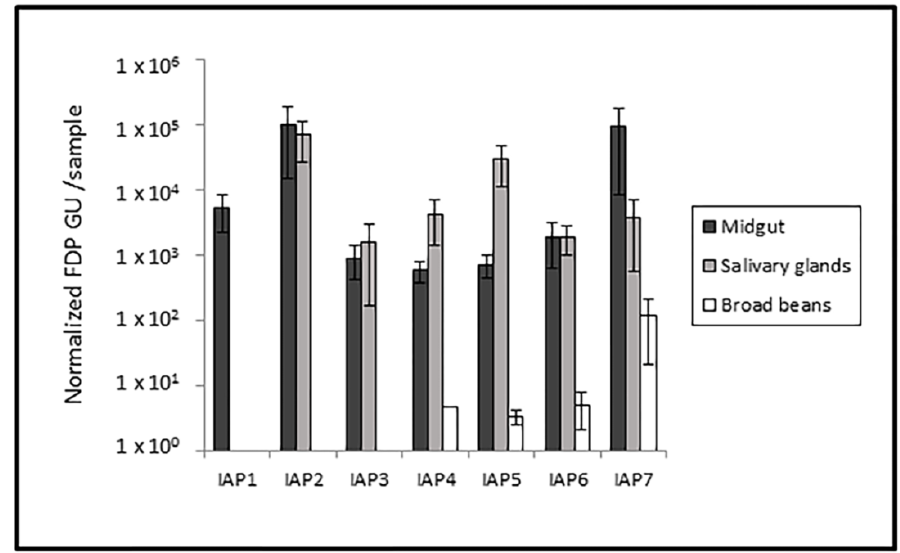
Figure 4. Average concentration of phytoplasma cells in midgut and salivary gland samples from FDP-positive E. variegatus corresponding to different IAPs, as well as in inoculated broad beans. Bars indicate the standard error.